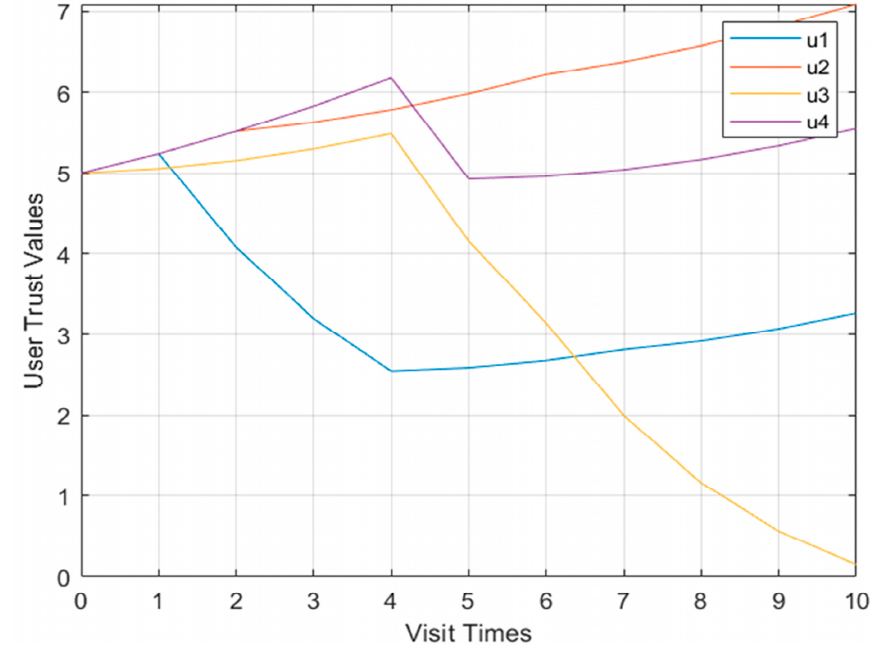
Figure 7. Model multi-user trust value change curve.